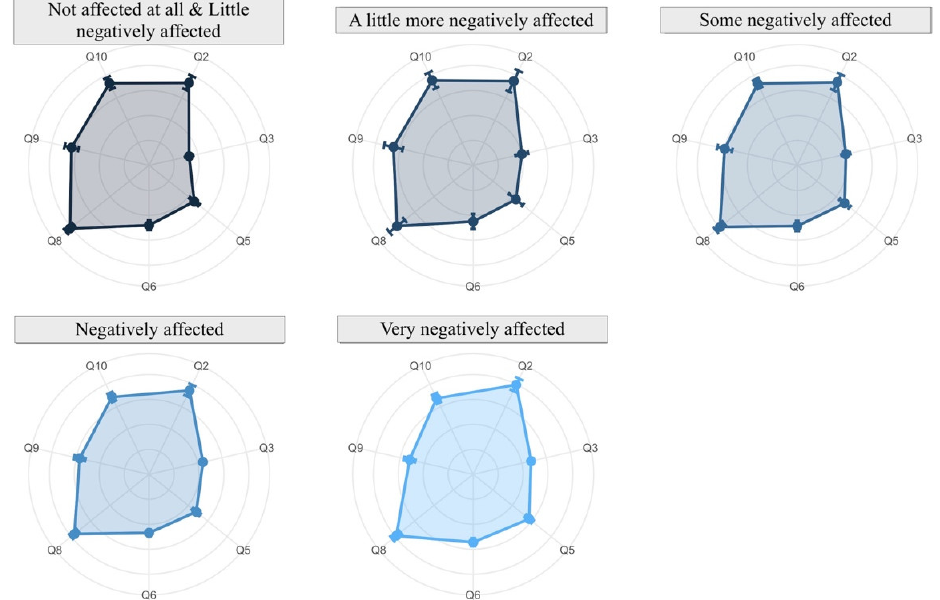
Figure 19. Affectation of research due to virtual teaching dedication (answers to Q11) related to other aspects.